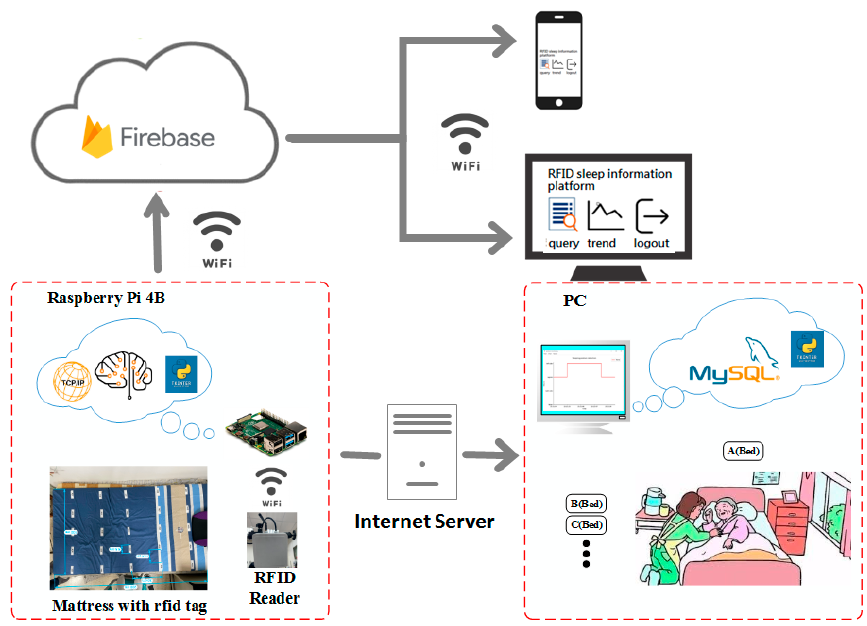
Figure 1. System architecture.